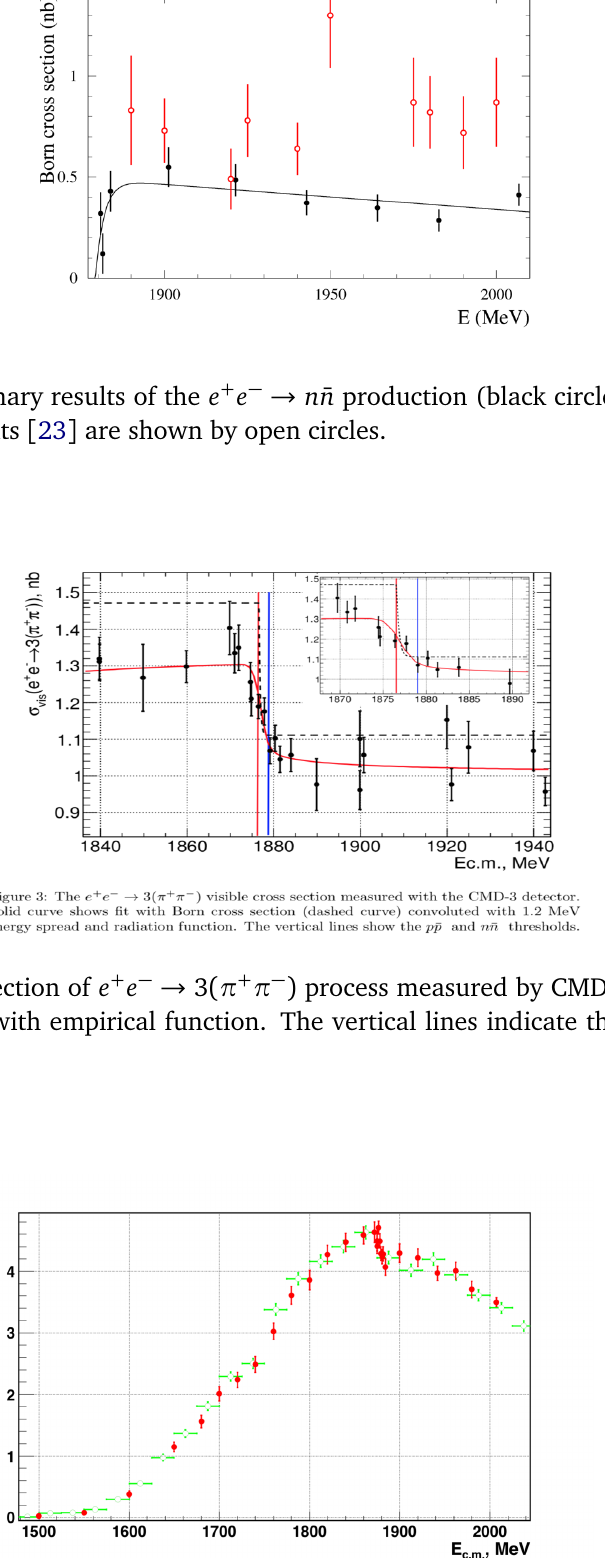
Figure 8: Cross section of e + e − → K + K − π + π − process measured by CMD-3